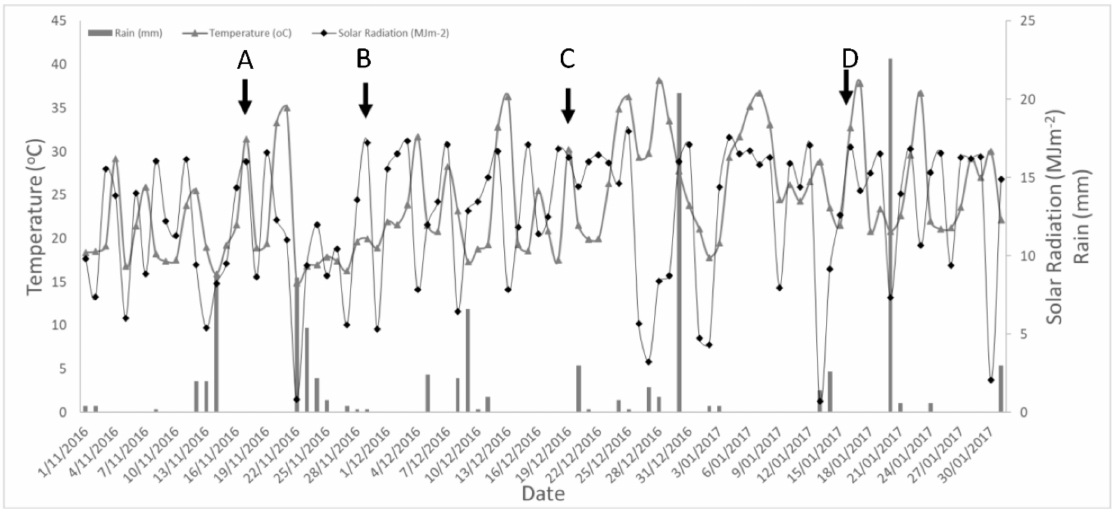
Figure 5. Meteorological data showing daily maximum temperature ( ◦ C) solar radiation (MJ m − 2 ) and rain (mm) in the Royal Parade for four different dates studied: ( A ) 17 November 2016, ( B ) 29 November 2016, ( C ) 19 December 2016, and ( D ) 16 January